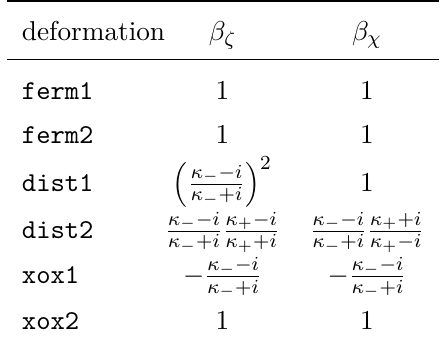
and β in eq. (2.10). They are included to ensure that χ ζ